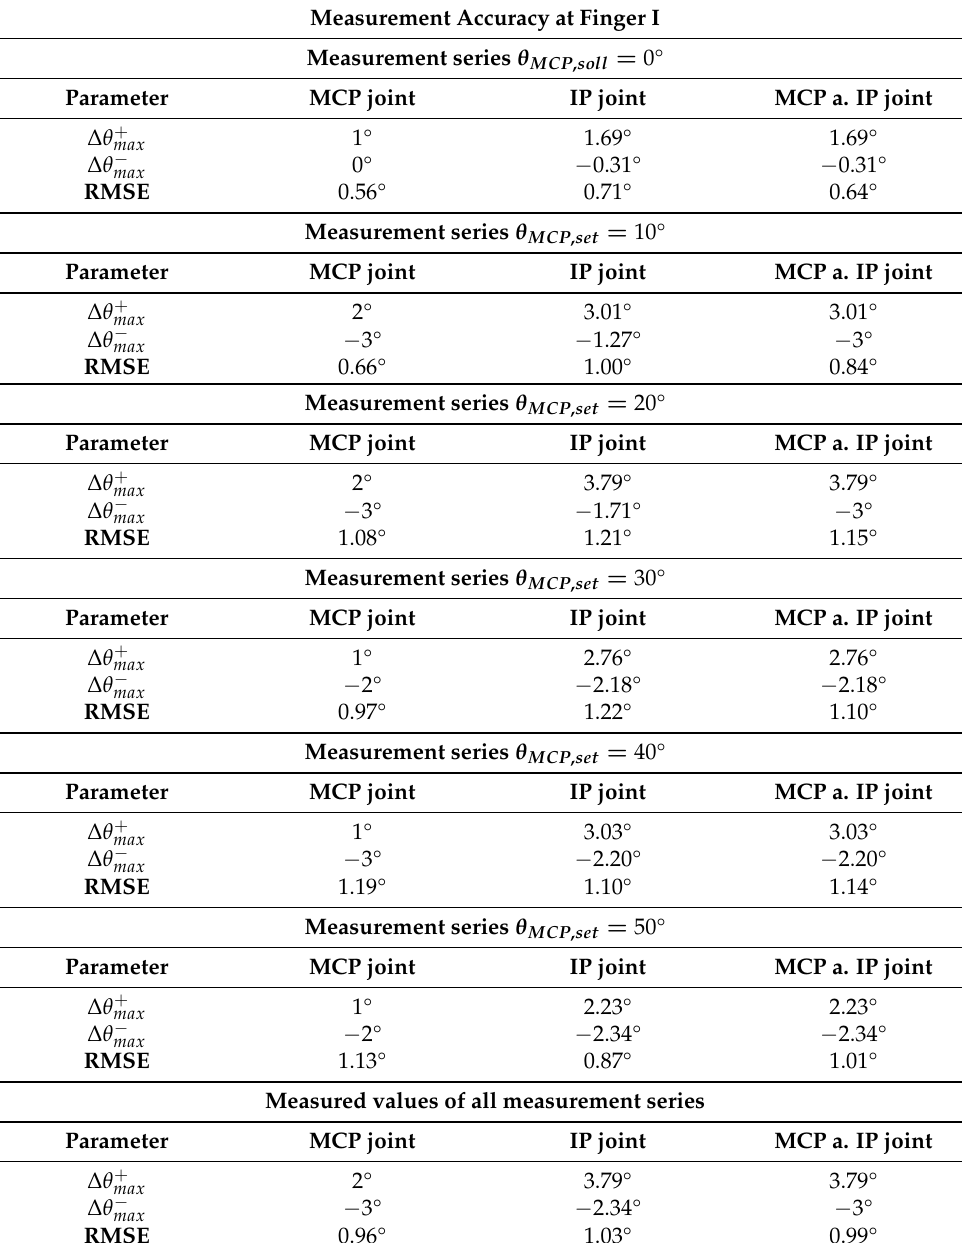
Table A8. Results of the measurement series on the measurement accuracy of the joint angles of finger I. Measurement series sorted by dependence on the predetermined angle θ MCP , set for the Metacar- pophalangeal joint. Results shown are the maximum positive ∆ θ + max and negative ∆ θ − max deviations, as well as the root-mean-square error (RMSE). Joints: Interphalangeal (IP), Metacarpophalangeal